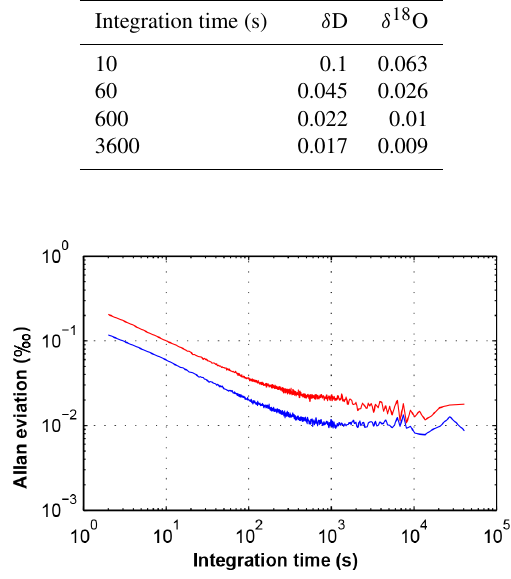
Figure 3. A 7h analysis of Allan deviation for δ D (red) and δ 18 O (blue) on the CRDS-CFA using isotopically homogenous water va-